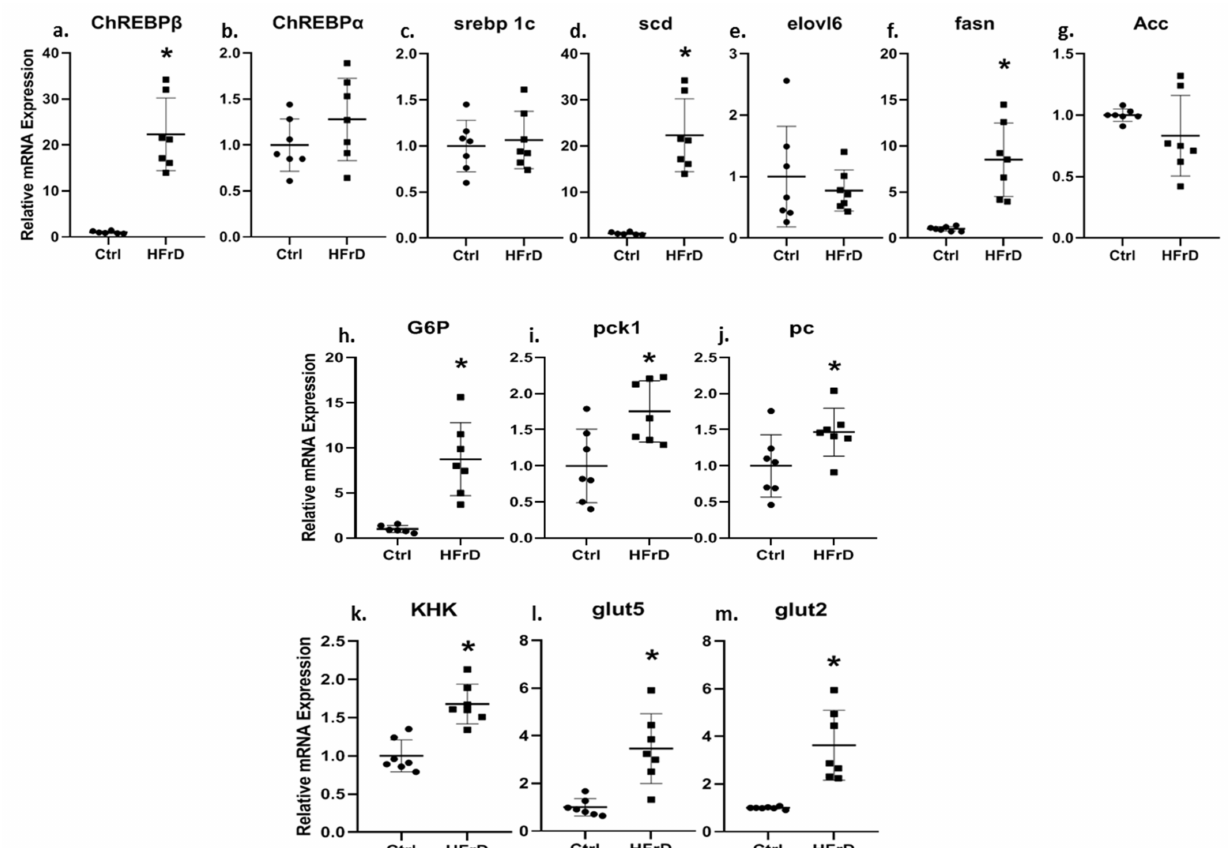
Figure 3. Fructose consumption increased ChREBP β and its downstream genes RNA expression. HFrD increased the expression of genes in the kidney that regulate de novo lipogenesis ( a – g ), gluconeogenesis ( h – j ) and fructose intake and metabolism ( k – m ). Gene expression was measured by real time PCR. * p ≤ 0.05. n =